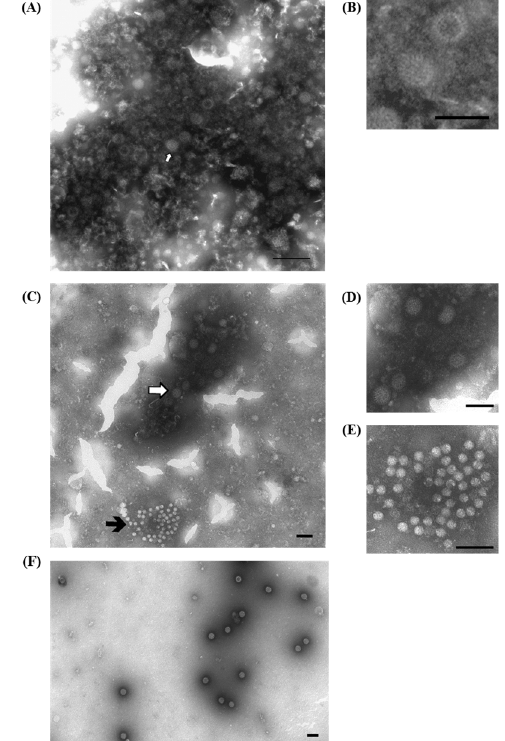
Figure 1. Electron micrograph of ultracentrifuged fecal contents from pigs with post-weaning enteritis. ( A ) A group of rotavirus particles ( ) with a dense halo of antibodies showing different levels of morphological integrity is visible; ( B ) Higher magnification of ( A ) showing two rotavirus particles with the typical inner shell, which in one case is penetrated by the negative stain (empty particle). Immuno-aggregation electron microscopy (IAEM) preparation with convalescent sera diluted 1:80. Negative staining (2% sodium phosphotungstate). TEM FEI Tecnai G2 Spirit, 85 kV. Bar = 200 nm; ( C ) A large group of rotavirus particles ( ) and a small group of small round fecal virus/enterovirus-like 28–30 nm particles ( ) are visible; ( D , E ) Higher magnifications of ( C ) showing respectively one group of rotavirus and one group of small round fecal virus/enterovirus-like virus. IAEM preparation with convalescent sera diluted 1:80. Negative staining (2% sodium phosphotungstate). TEM Philips CM10, 80 kV. Bar = 100 nm; ( F ) IAEM negative control. Dispersed rotavirus particles. TEM Philips CM10, 80 kV. Bar = 100